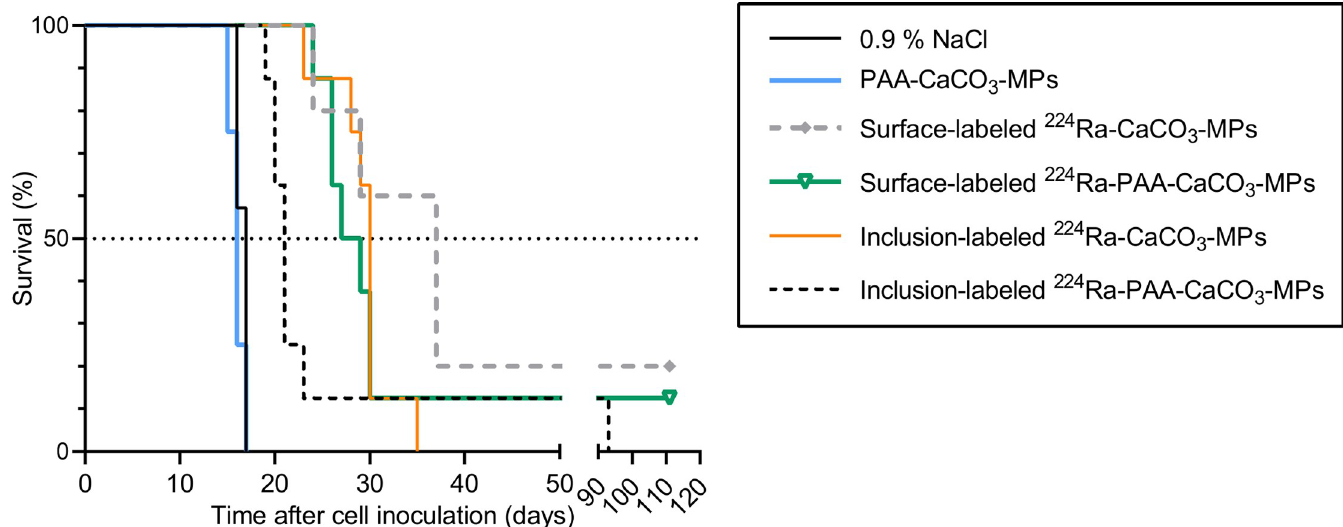
Fig 6. Kaplan-Meier survival curves of athymic nude mice inoculated intraperitoneally with 1 × 10 6 ES-2 cells and treated 1 day later with intraperitoneal injections of 0.9% NaCl, PAA-coated CaCO 3 microparticles or 224 Ra-CaCO 3 microparticles both with and without PAA coating with an activity dose ranging from 138–474 kBq/kg body weight. N = 4–8 animals per